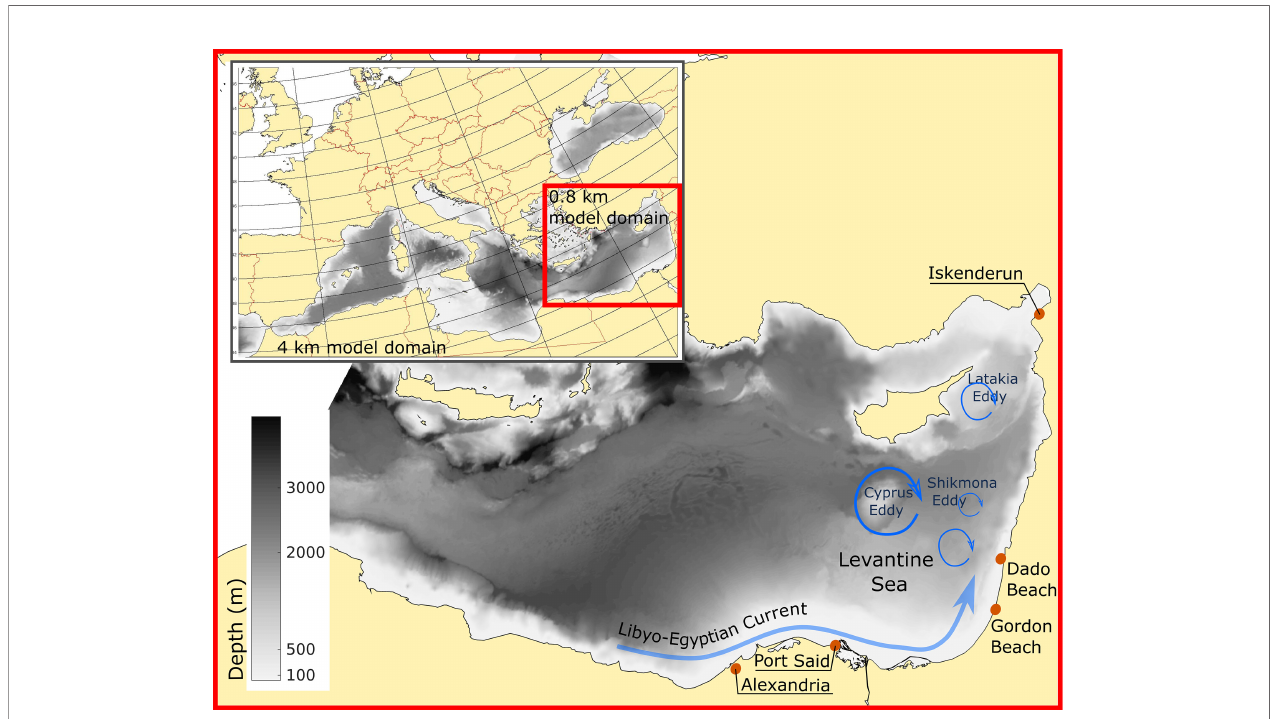
FIGURE 1 | Study area: Bathymetric map of the Mediterranean Sea, with main circulation patterns (blue arrows) and release and target beaches explored in the study (red